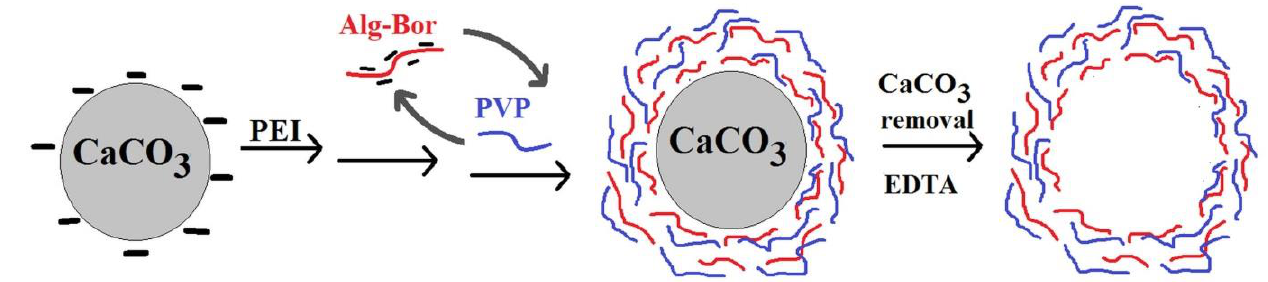
Figure 11. Elaboration of the glucose-responsive microcapsules based on AlgPBA and PVP (Adapted with permission from [97]. Copyright © 2023 Elsevier B.V. All rights reserved). Onto CaCO 3 microparticles, pretreated with poly(ethylenimine) (PEI), was firstly de-